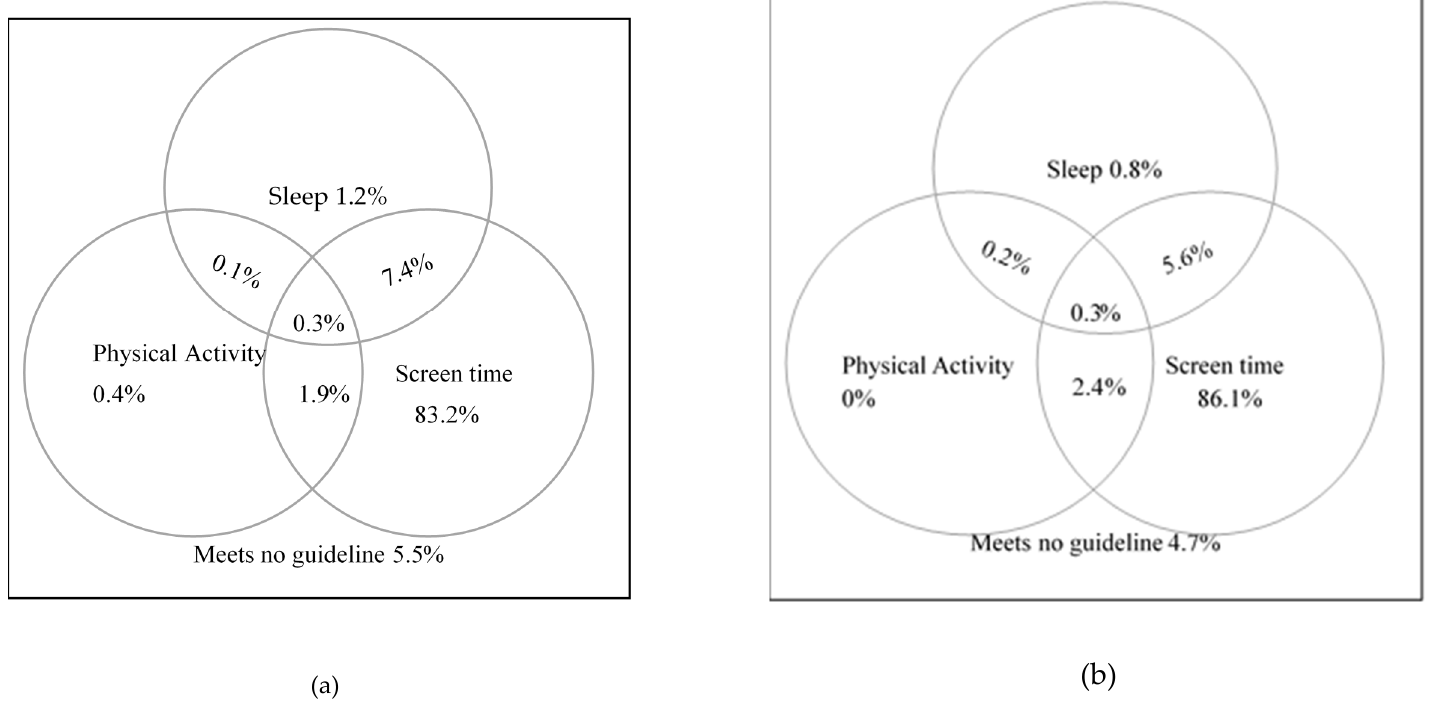
Figure 1. Percentages meeting 24-hour movement guidelines among male ( a ) and female ( b ) adolescents.